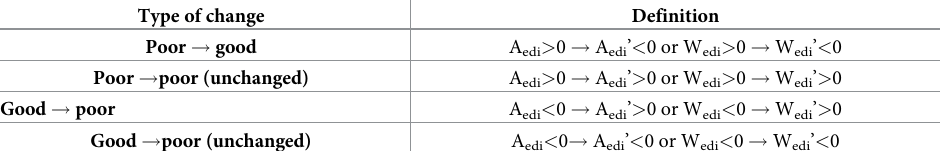
Table 1. Comparison of the two results (statistics of the number of counties and cities with four change patterns of pollutants).